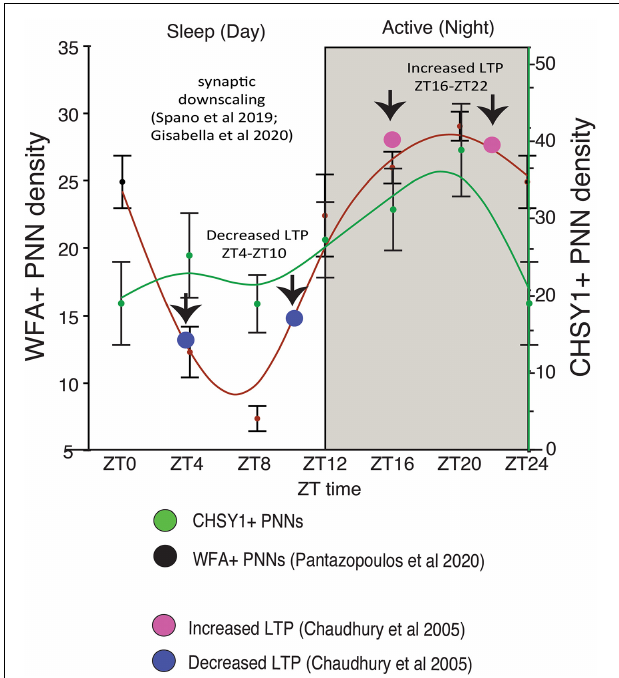
FIGURE 3 | Diurnal PNN Rhythms Coincide with Rhythms in CHSY1 Expression and Memory Consolidation Processes. Diurnal rhythms in the numerical density of WFA+ PNNs decreases during the day as mice sleep, reaching the lowest density in WFA+ PNN numbers between ZT 4-ZT 10 (red curved line). This coincides with decreased expression of CHSY1 PNNs (green curved line) and the reported daytime decrease in LTP [blue circles, (Chaudhury et al., 2005)]. This decrease in PNNs also coincides with reported broad synaptic downscaling in this region (Spano et al., 2019; Gisabella et al., 2020). In comparison, the numerical density of WFA+ and CHSY1 immunoreactive PNNs peaks during the dark at ∼ ZT 20 during the active period for nocturnal mice, coinciding with the reported increase in LTP at night in mice [pink circles, (Chaudhury et al., 2005)]. These results suggest that decreases in PNN composition during sleep coinciding with synaptic downscaling and decreased LTP, potentially allowing for memory consolidation. PNN composition is restored during the active wake periods, in part through CHSY1